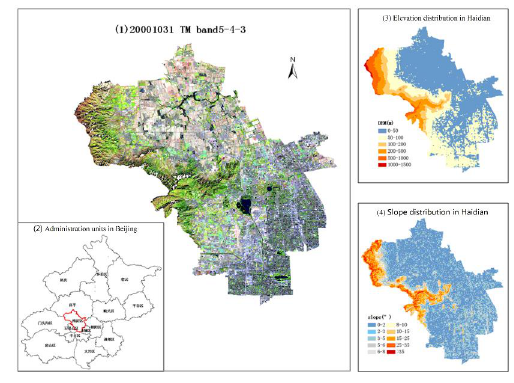
Figure.2 Landform information in Haidian